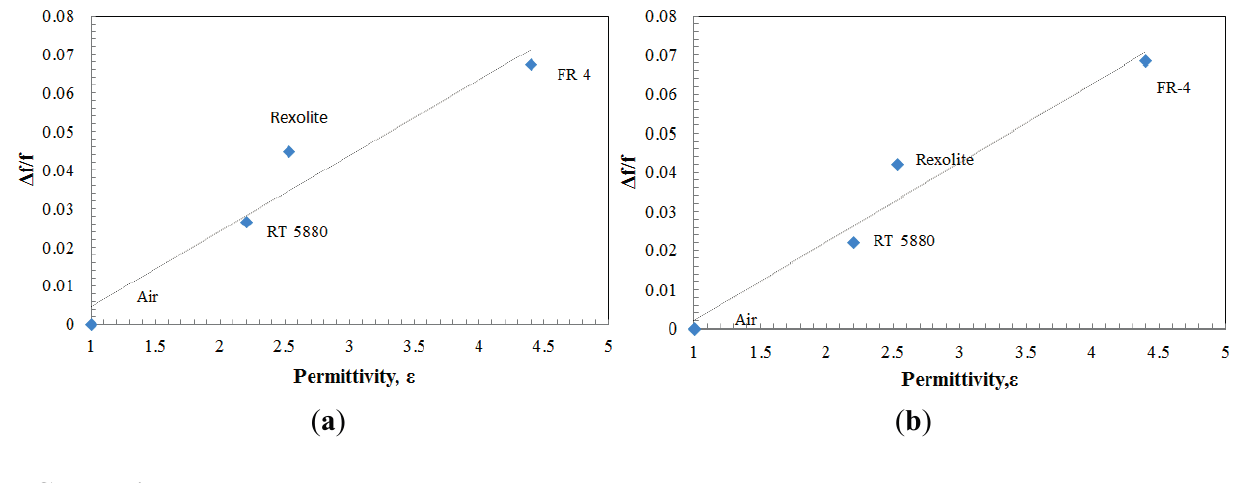
Figure 13. Relative shift ( Δ f/f ( b ) centered-gap